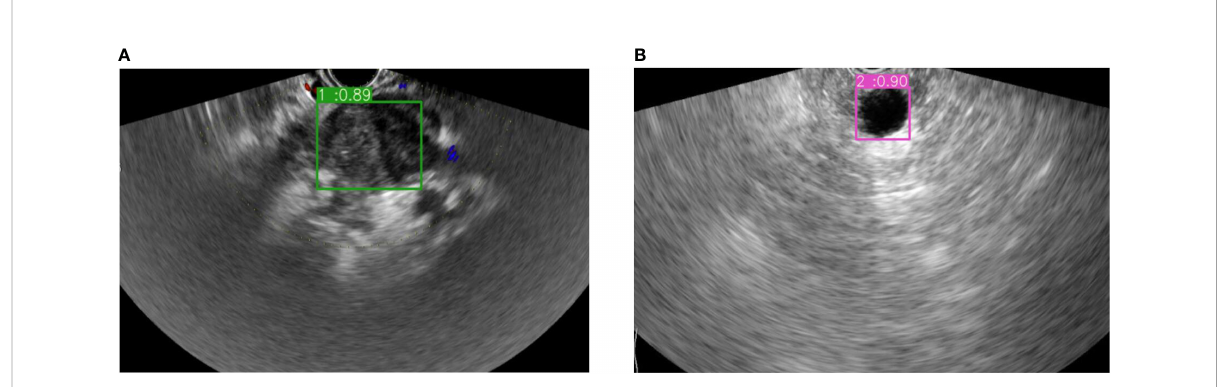
FIGURE 4 The example of bounding boxes for real-time auxiliary diagnosis in the test datasets. (A) Pancreatic cancer prediction and its possibility. (B) Non- pancreatic cancer lesion prediction and its